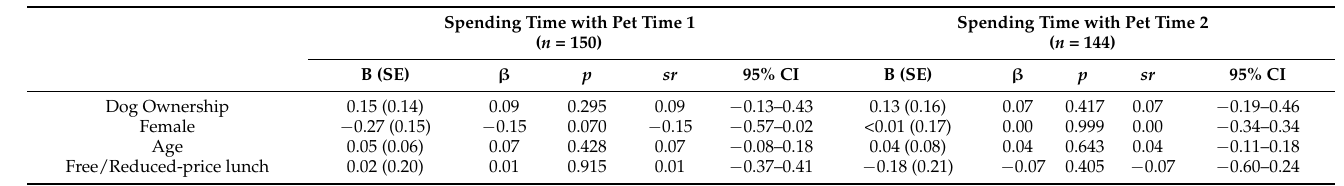
Table 7. Dog ownership (vs. non-dog pet ownership) predicting spending time with a pet as a stress-coping strategy, controlling for gender, age, and free/reduced-price lunch